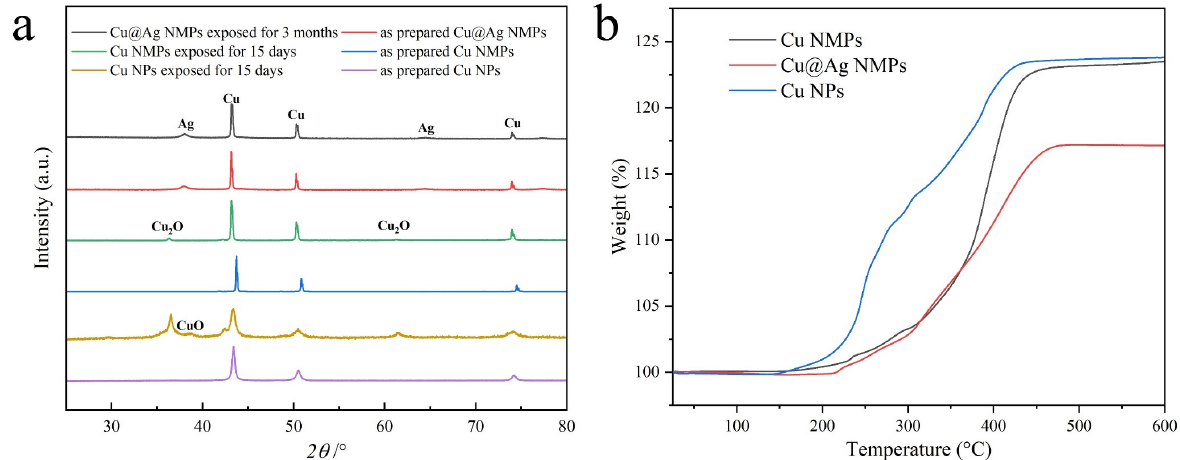
Figure 6. ( a ) XRD patterns of the as-synthesized Cu@Ag NMPs, the Cu NMPs and the Cu nanopar- ticles before and after exposure in air. ( b ) TG curves of the as-synthesized Cu@Ag NMPs, the Cu NMPs, and the Cu nanoparticles.